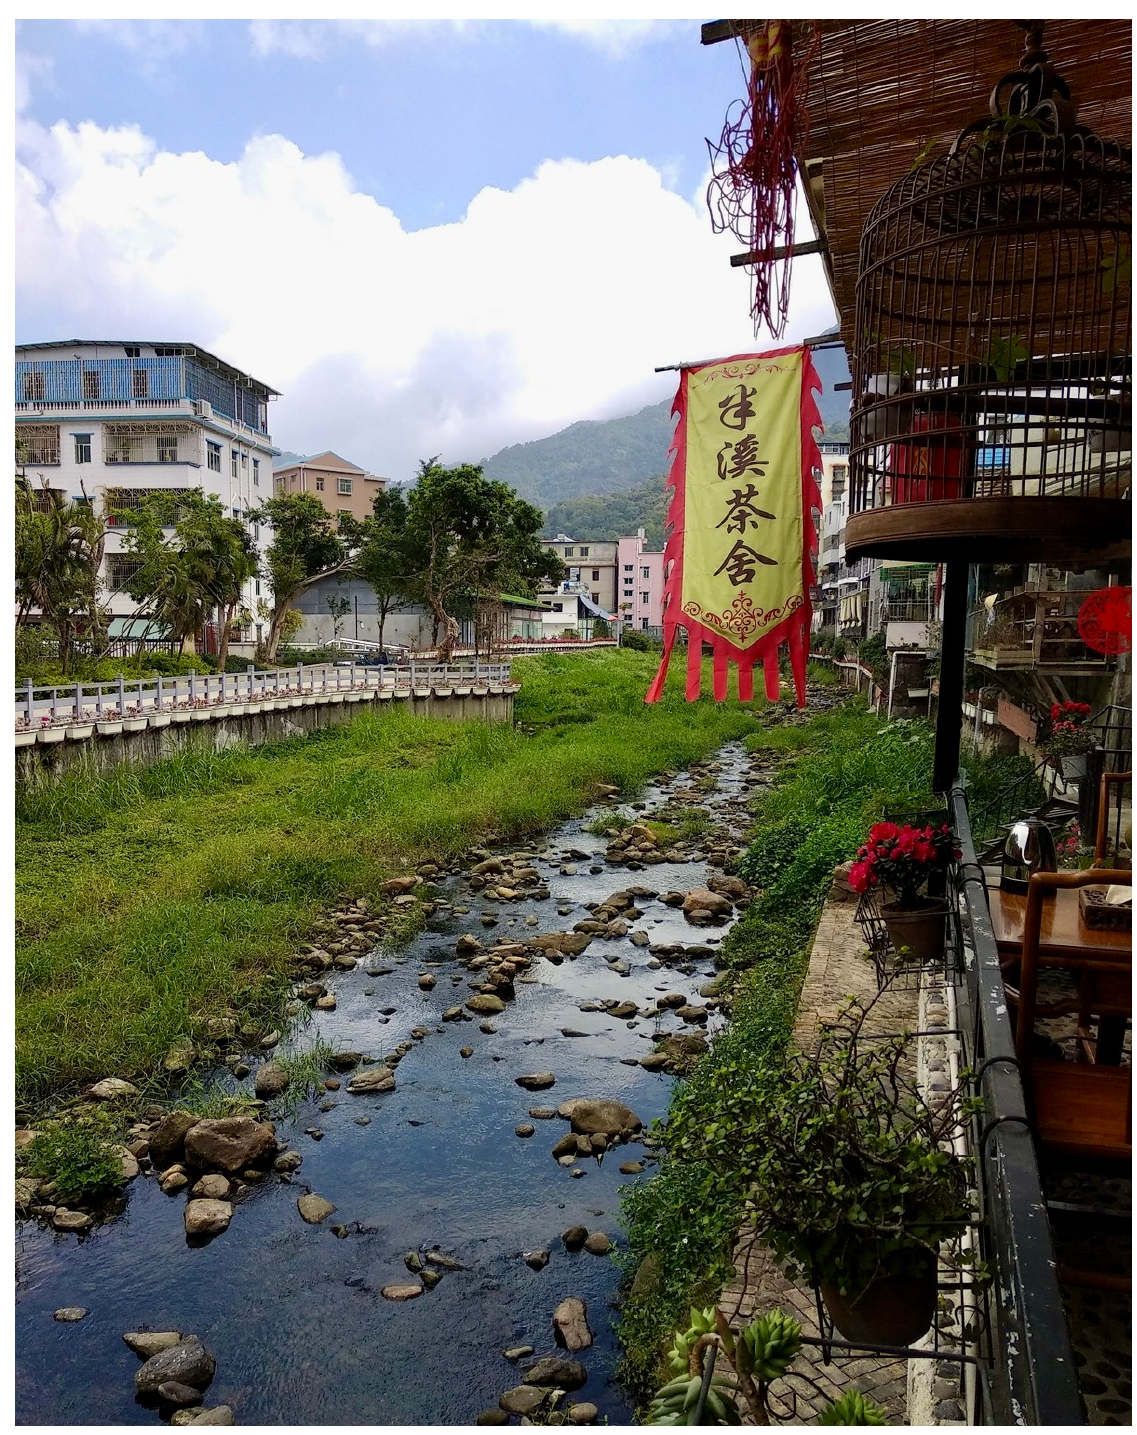
Figure 2 View of Wutong mountain from a tea house in the